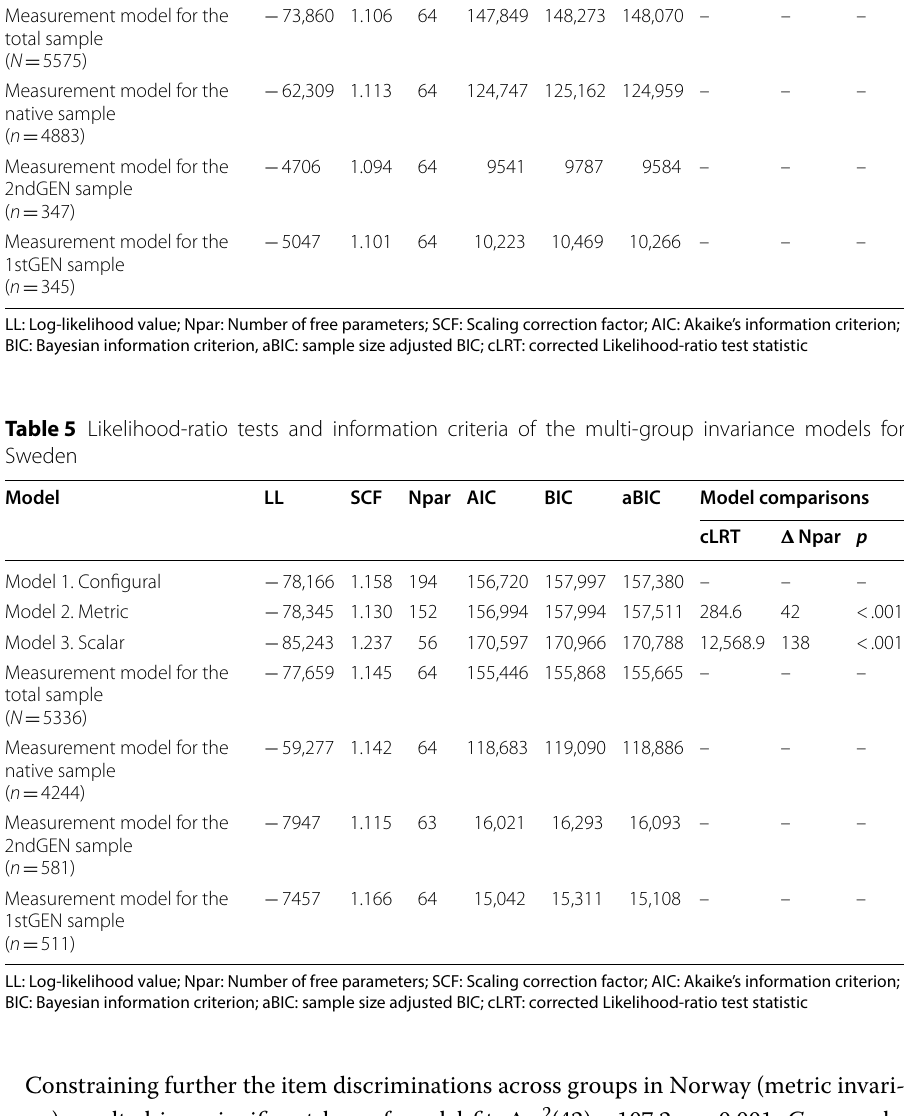
LL: Log-likelihood value; Npar: Number of free parameters; SCF: Scaling correction factor; AIC: Akaike’s information criterion; BIC: Bayesian information criterion; aBIC: sample size adjusted BIC; cLRT: corrected Likelihood-ratio test statistic